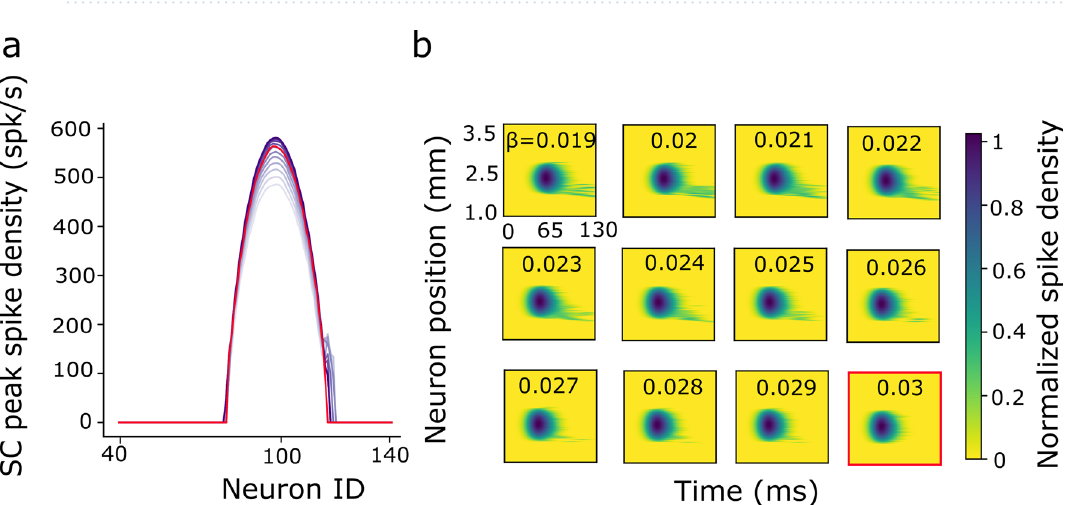
Figure 7. Burst profiles of the SC population in the network in response to the external input current with varying temporal properties (β, I 0 ), selected such that the total number of input spikes sent to the SC motor map decreased with increasing β (see Fig. 2c,d). Same format as in Fig. 5. ( a ) Peak firing rates of the neural population in the motor map. Red curve corresponds to the default (β = 0.03 s −1 ). The SC peak firing rate increases with β and reaches a plateau around the default. The total number of SC spikes remained constant (see also Fig. 2g,h, purple data). ( b ) Firing patterns of the neural population as function of time for the different β values. Note that burst durations decrease with increasing